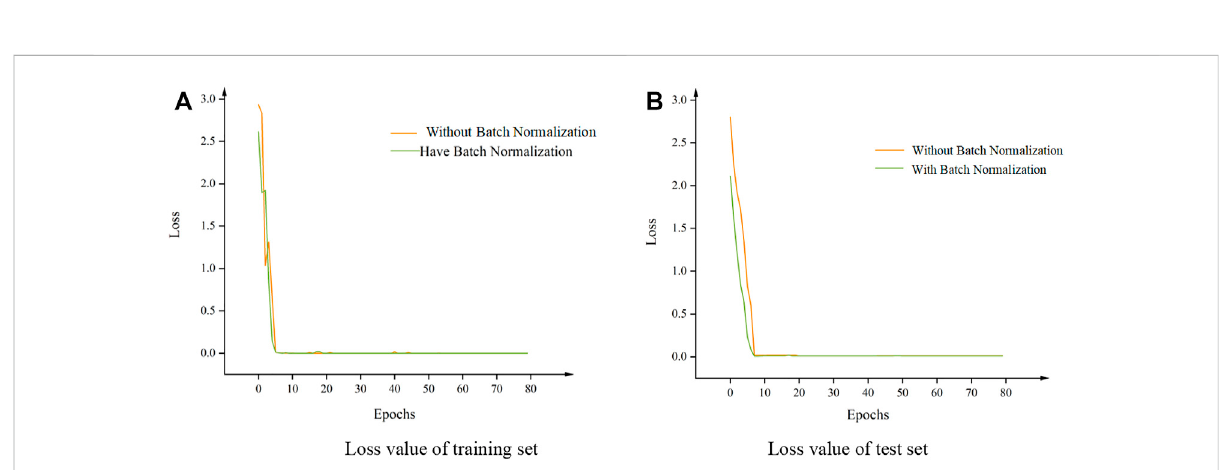
FIGURE 7 Comparison of step loss rate. (A) Loss value of training set (B) Loss value of test